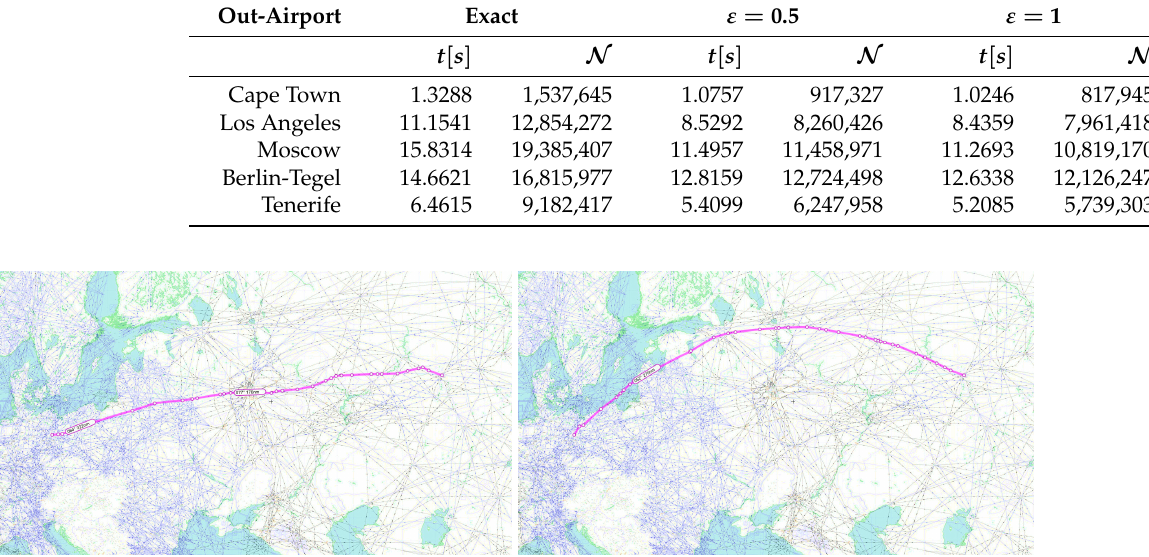
Figure 9. Least consumption ( left ) and fastest ( right ) routes from Berlin to Yekaterinburg. Source: